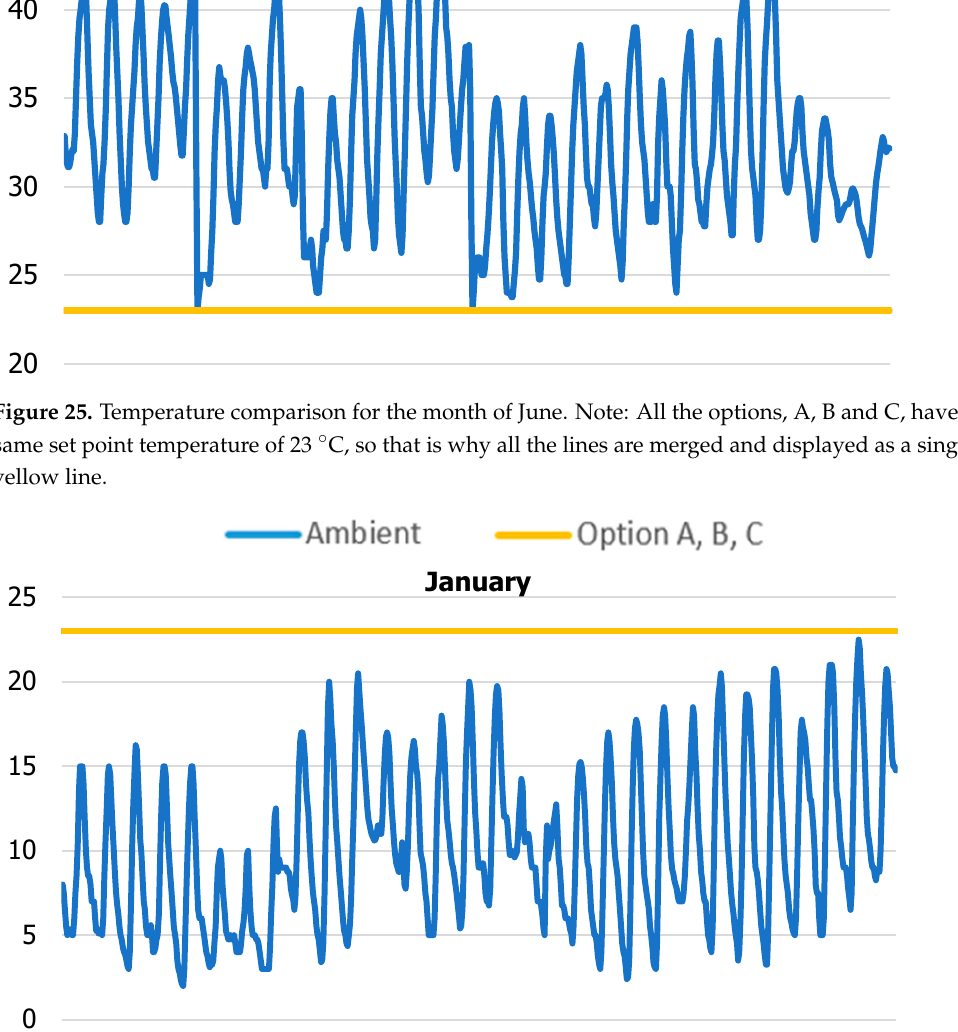
Figure 26. Temperature comparison for the month of January. Note: All the options, A, B and C, have a same set point temperature of 23 °C, so that is why all the lines are merged and displayed a single yellow line.